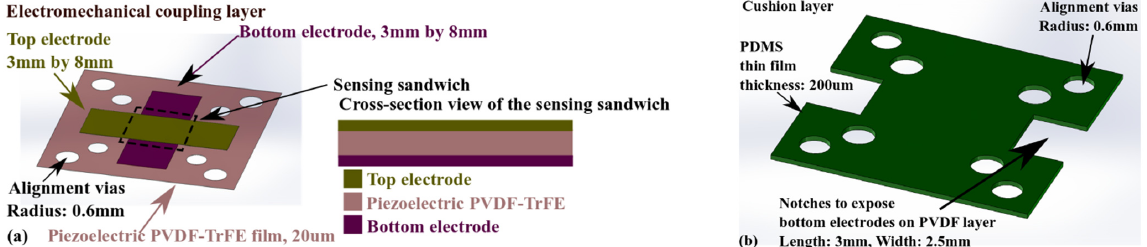
Figure 3. Detailed designs of structures for laser micromachining. ( a ) The piezoelectric PVDF ‐ TrFE layer, ( b ) The PDMS cushion layer.